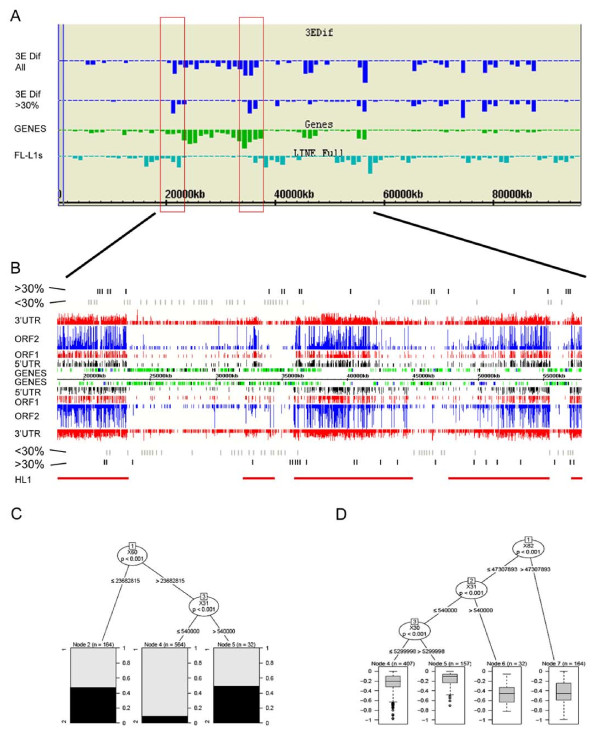
Genes with strong downregulation cluster within and flanking domains with high L1 density on chromosome 17. (a) Genome Environment Browser (GEB) histogram display showing distribution of chromosome 17 genes with ≥ 30% downregulation compared with all downregulated genes. Gene density (green) and full-length L1 (FL-L1) density (light blue) are also shown. Boxes highlight >30% genes enriched in high L1 domains flanking a large gene-rich region. (b) GEB detail view of Mb 18-58. High L1 density (HL1) domains are visualised as regions with high density of vertical lines (L1 5' untranslated region (UTR), open reading frame (ORF)1, ORF2 and 3' UTR) and are highlighted for illustrative purposes with horizontal red lines. Genes are represented as green boxes. Those showing >30% and <30%downregulation are blue and black, respectively. Downregulated classes are also highlighted by black (>30%) and grey (<30%) bars above and below the GEB display. (c) Classification tree comparing 20% most downregulated genes on chromosome 17 with all other genes. The first split divides the chromosome into two, proximal and distal of 56 Mb, based on the distance between the gene and a unique L1VL4 element at 80.4 Mb (×60). On the right side of the tree, representing the proximal 56 Mb, the model suggests genes located in HL1 domains larger than 0.54 Mb (×31) had a much higher probability of being silenced. (d) Regression tree for chromosome 17 highlights equivalent L1 domain related features. At the terminal nodes, the lower the expression values, the stronger the gene silencing effect. The tree defines that to remain active the gene should be (1) within the first 56 Mb of the chromosome (node 1 split, ×82), (2) associated with a relatively small HL1, or no HL1 at all (node 2 split, ×31), and (3) associated with a low L1 density (LL1) domain at least approximately 5.3 Mb large (node 3 split, ×30). Two large LL1 domains on chromosome 17 fit this description. Y-axis scale on box and whisker plots shows expression level of genes relative to untreated control in log2 scale.